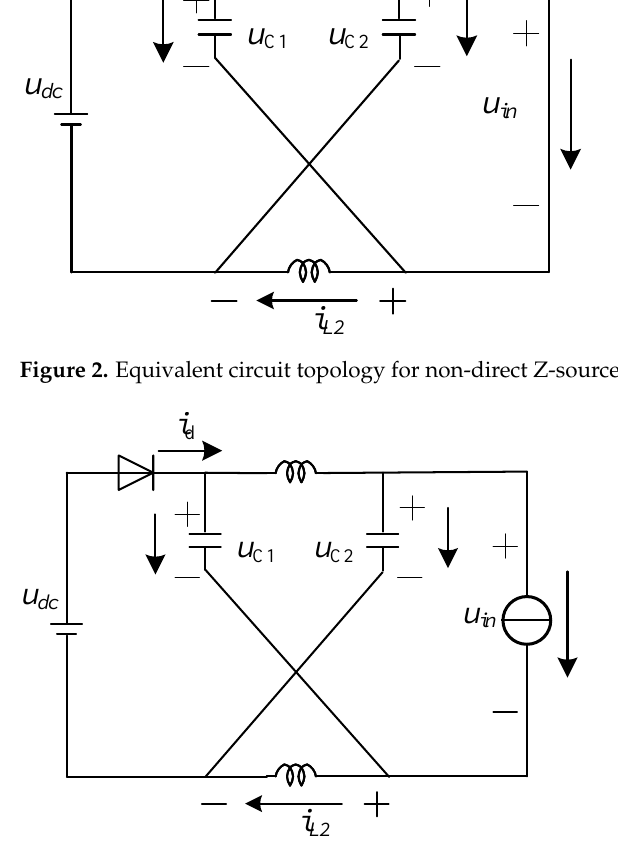
Figure 3. Equivalent circuit topology for direct Z-source